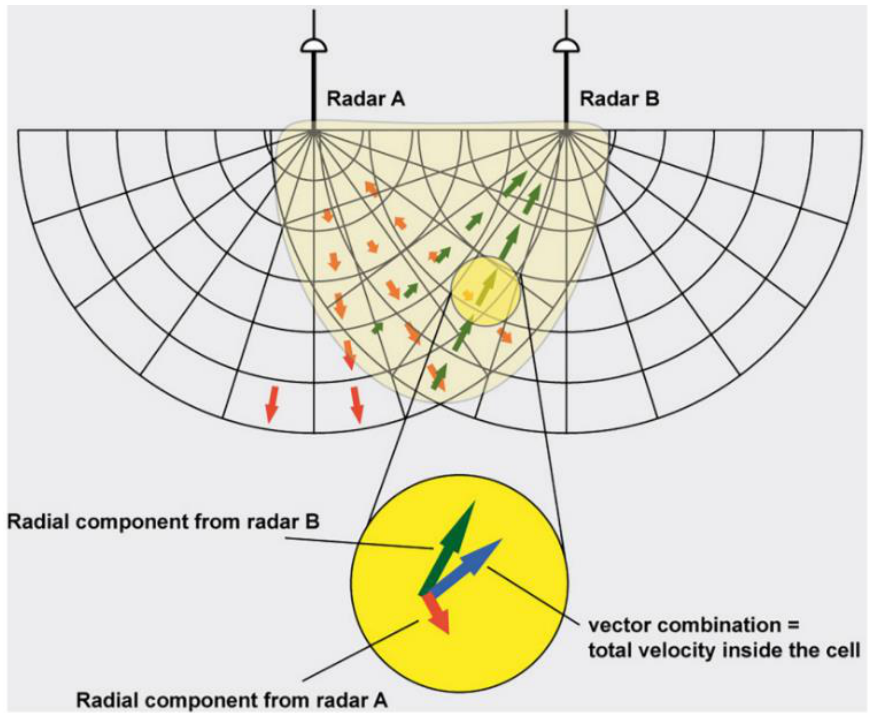
Figure 3. The concept of surface current extraction from two HFR site networks (Mantovani et al.,